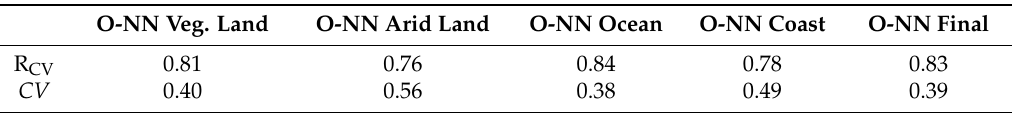
Table 3. Performance of the final optimal neural network (O-NN) compared with those of the O-NNs trained for different